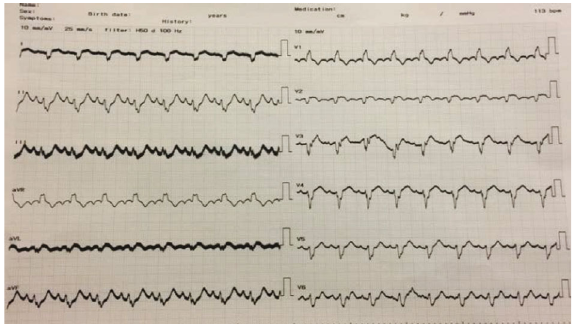
Figure 2: Electrocardiogram after primary PCI: it showed resolution of STEMI.